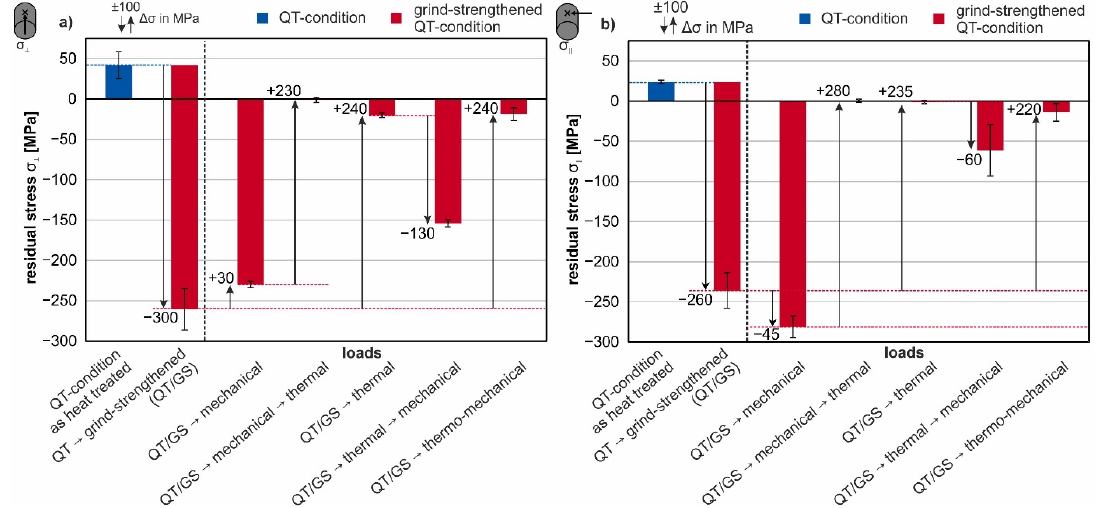
Figure 10. Surface residual stresses after grind-strengthening and various loads for the material in QT-condition ( a ) transverse to grinding direction ( b ) parallel to grinding direction.